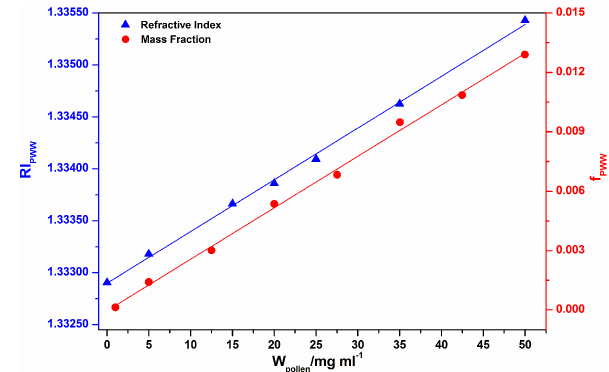
Figure 6. The mass fraction ( f PWW , red circles) and refractive in- dex (RI PWW , blue triangles) of PWW solutions versus the pollen suspension concentration (W pollen ) . The red and blue lines are lin- ear fits to the data with adjusted- R 2 values of 0.9969 and 0.9981,